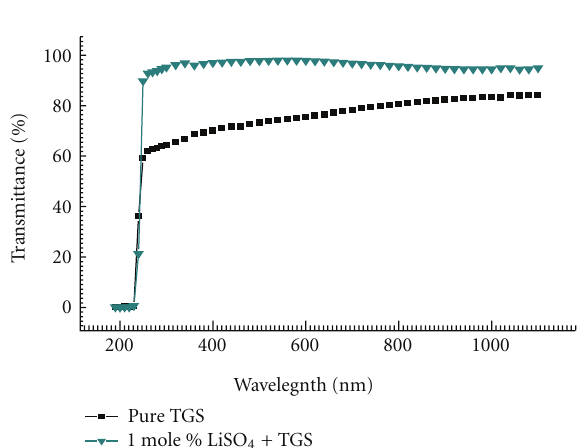
Figure 2: UV-visible transmittance spectra for pure and LiSO 4 - doped TGS